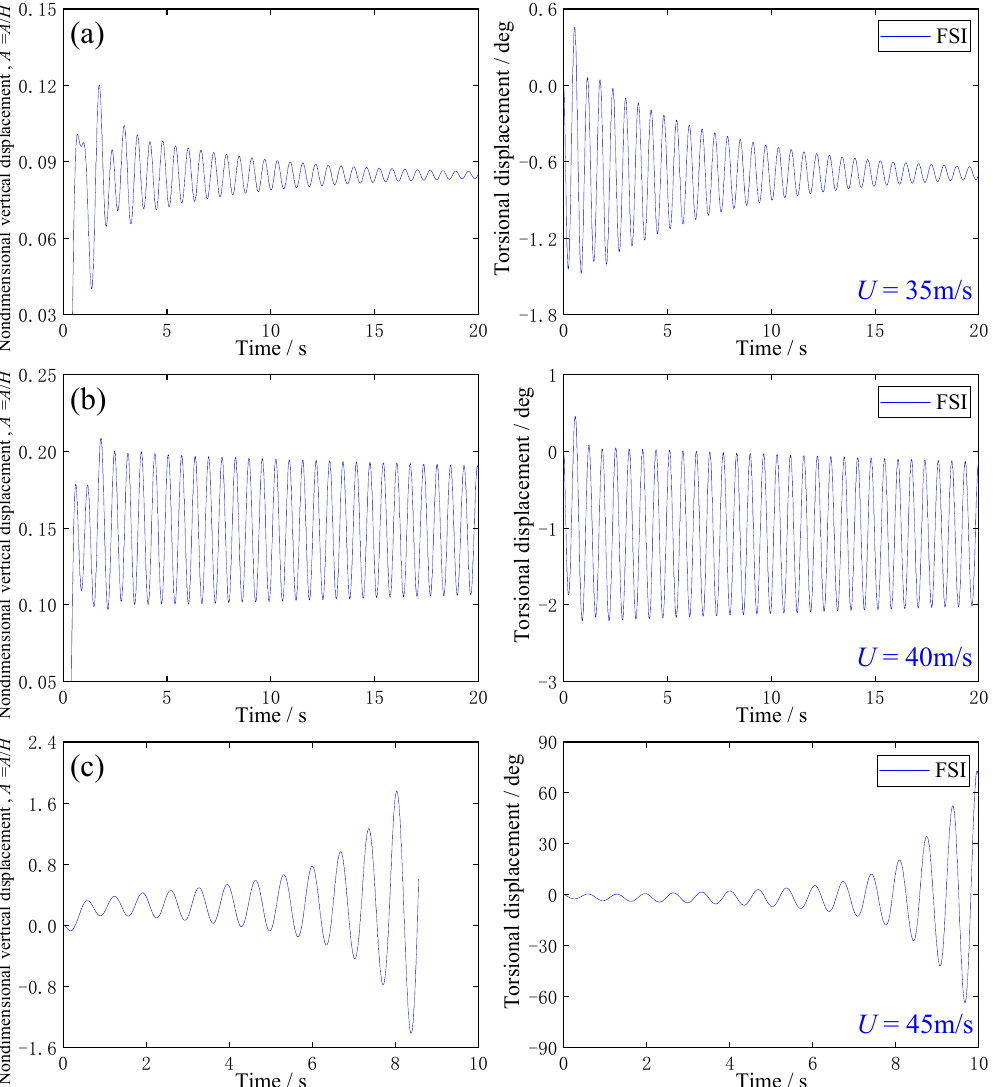
equal to that for the wind speeds of 4.375 m/s, and 5.625 m/s, respectively. Figure 10 shows the numerical results of wind-induced vibration responses of the main deck section by ROM method for incoming wind speeds of 35 m/s, 40 m/s, and 45 m/s for the prototype main deck section, respectively.